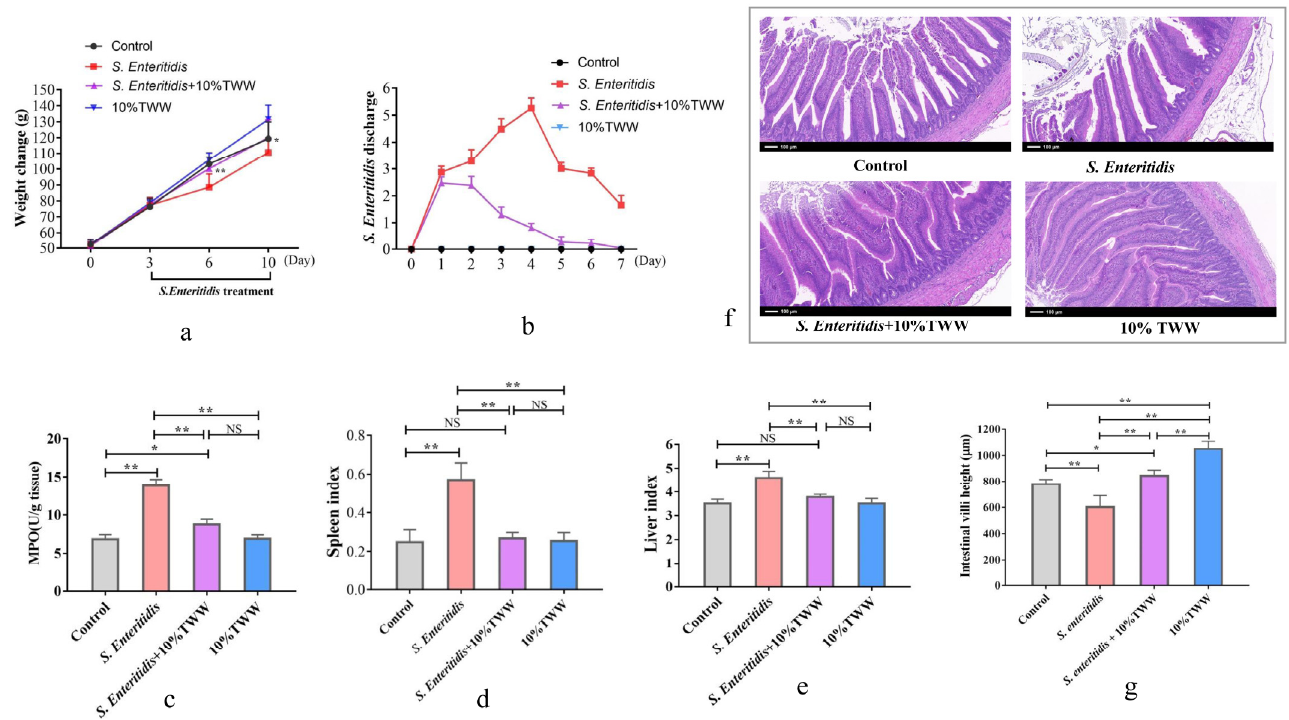
Figure 4. TWW supplementation reduces the pathological changes of chicks infected with S. enter- itidis . ( a ) Body weight changes in chicken. ( b ) S. enteritidis discharge in feces (×log10cfu). ( c ) Myeloperoxidase (MPO) activity in serum. ( d , e ) The relative weights of the spleen and liver in chicken after S. enteritidis infection. ( f ) Histopathological examination of the jejunum (HE staining ×100). ( g ) The intestine villi height of jejunum. Values presented as means ± SEM. * p < 0.05, ** p < 0.01, compared between the indicated groups. NS: no significance between the indicated groups.